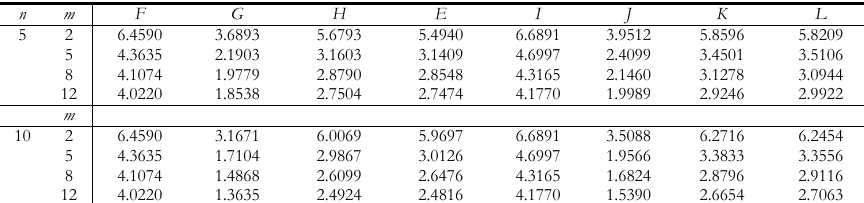
The expected interval length of prediction intervals